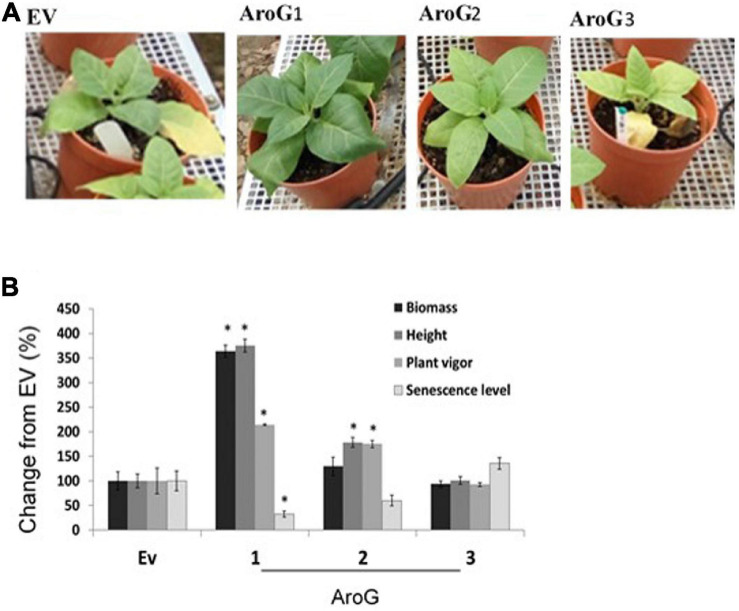
The ability of the transgenic plants overexpressing the bacterial AroG to cope with salt stress. (A) The phenotype of representative plants from each group 21 days after the salt-stress (150 mM) period. (B) The graph shows the% changes in different growth parameters of AroG lines #1, #2, #3 (n = 8–10) from EV (n = 7) 21 days after irrigation with 150 mM salt. EV is marked as 100%. Data are presented as the mean (±) SE. Significance (p ≤ 0.05) compared to EV is marked by asterisks.